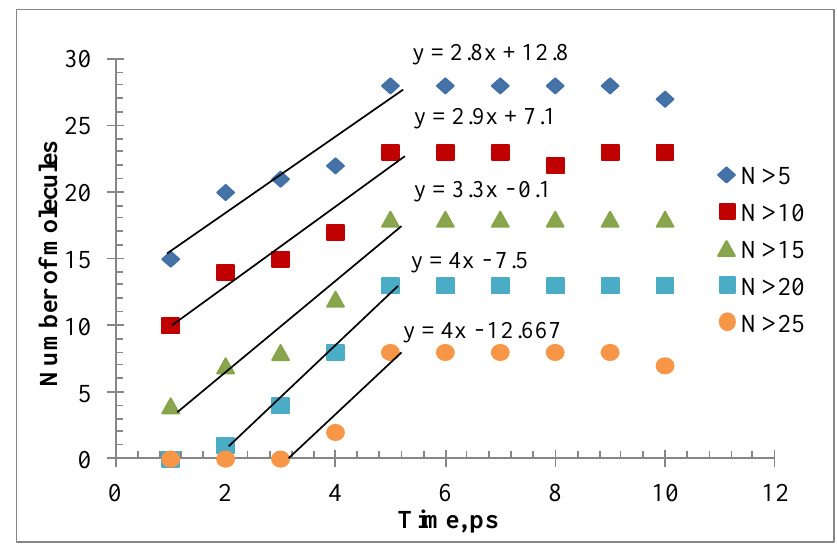
Figure 10. Evolution of the number of molecules forming clusters with time for the solution concentration of 44 g/L at S = 1.28, without the presence of electric potential.